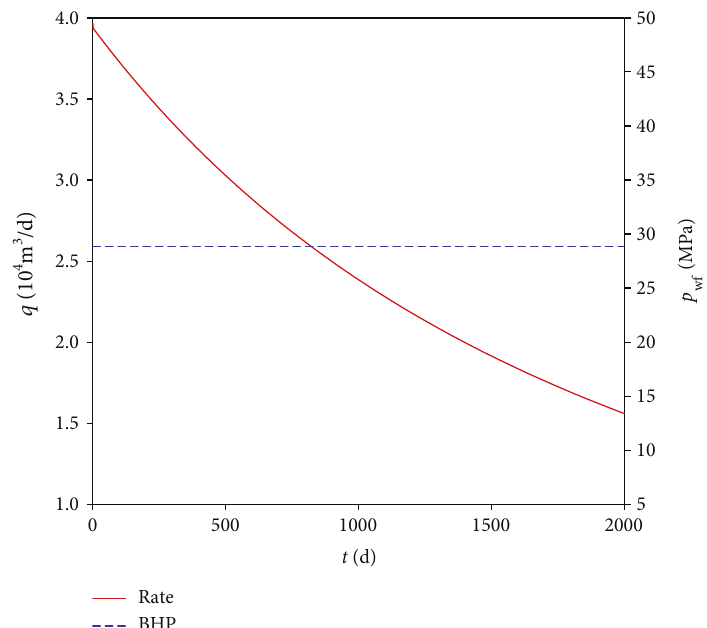
Figure 8: Production history of the gas well producing at a constant BHP.